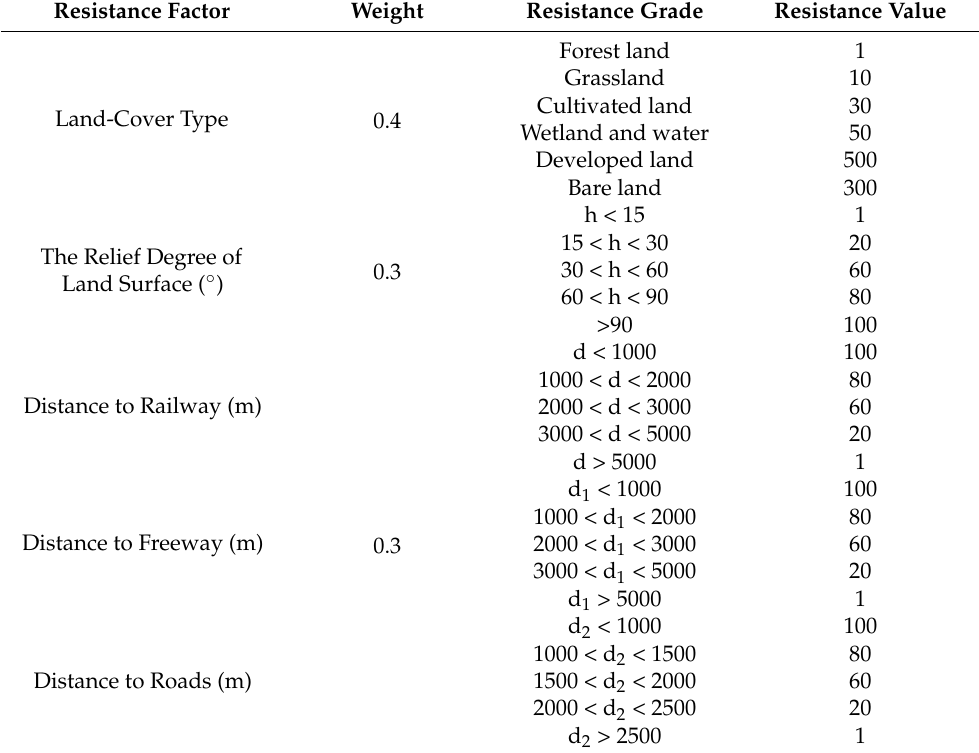
Table 1. Factor grades and weights in the ecological resistance